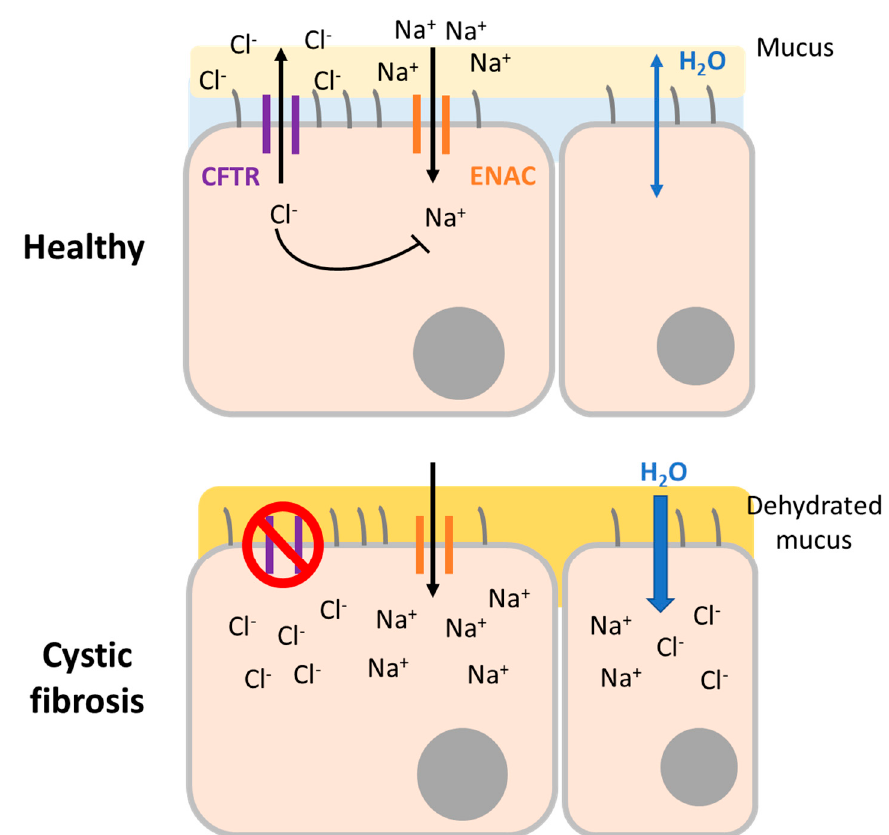
Figure 2. Pathophysiology of CF. Comparison between airway surface from a healthy (top) individual and a CF patient (bottom). In a normal situation, the cystic fibrosis transmembrane conductance regulator (CFTR) channel secretes chloride ions and inhibits sodium ions’ entrance, allowing water to hydrate the mucus by osmosis. When CFTR is mutated, ions are kept inside the cell and water moves inside the cell by osmosis, dehydrating the mucus and impeding mucus clearance from the airways.